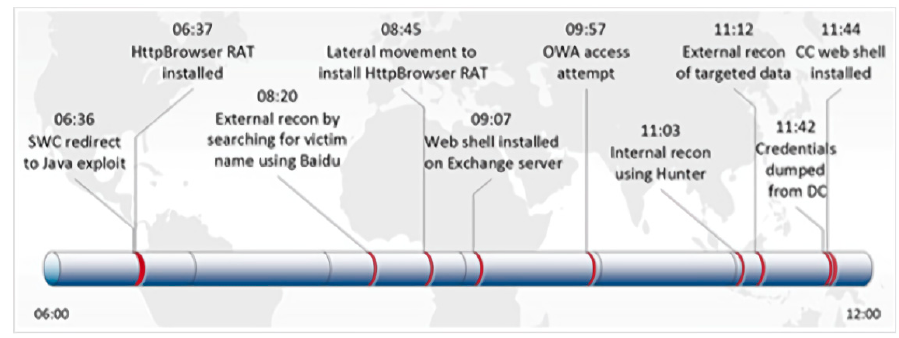
Figure 5. Timeline, in eastern-time, of TG-3390’s initial entry into a victim’s network.